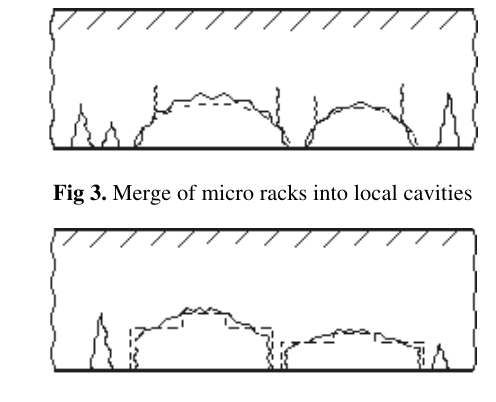
Fig 4. Formation of cavities in the form of a rectangular step